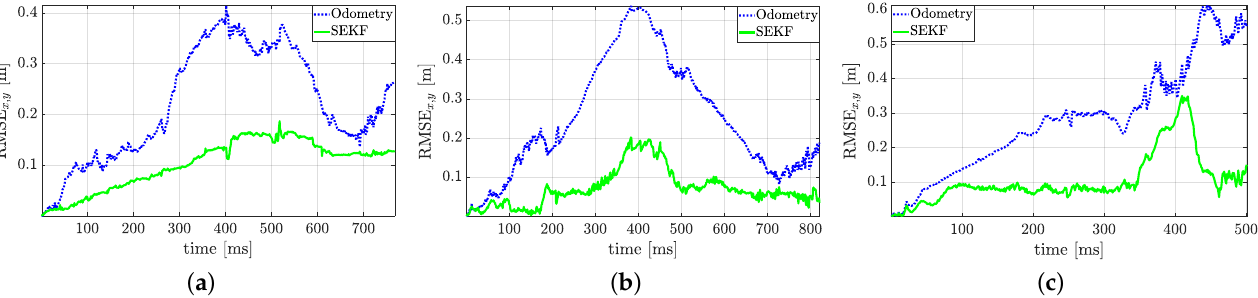
Figure 12. Position RMSE time evolution during localisation for ( a ) the sample trajectory of Figure 11a, ( b ) the sample trajectory of Figure 11b, ( c ) the sample trajectory of Figure 11c.